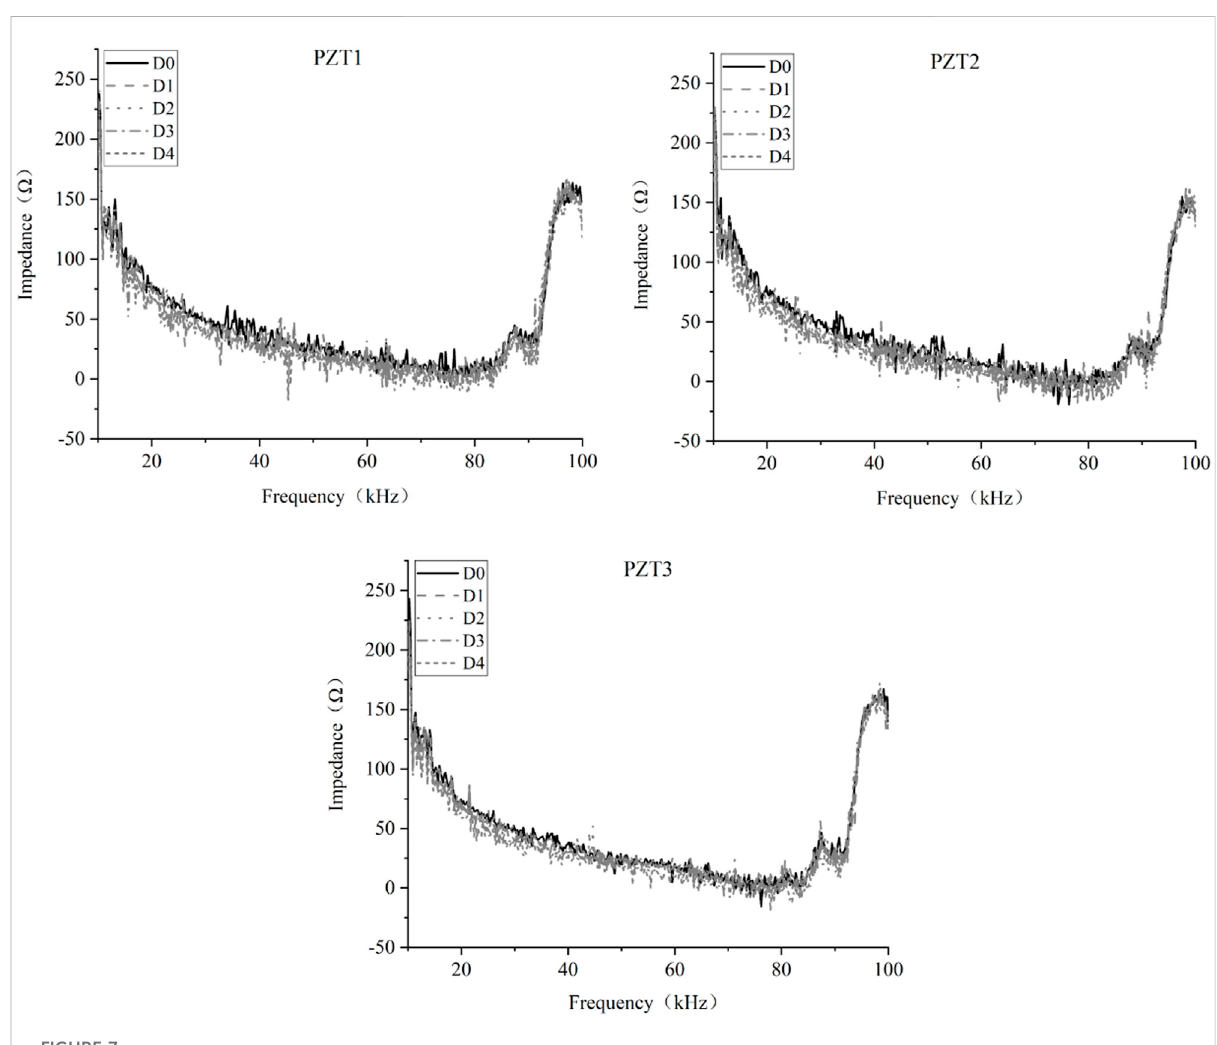
FIGURE 7 Impedance curve of the PZT sensors of BE1 with different damage